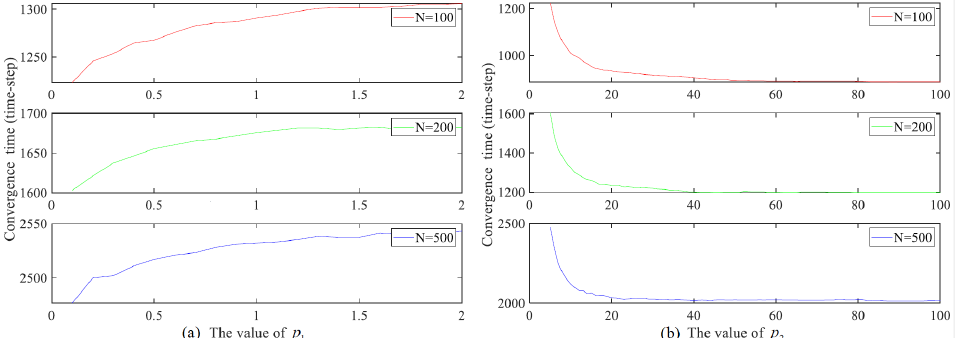
Figure 4. The process of one evolution with N = 200, L = 7, p 1 = 0.1, p 2 = 5. The red individual represents the information UAV.